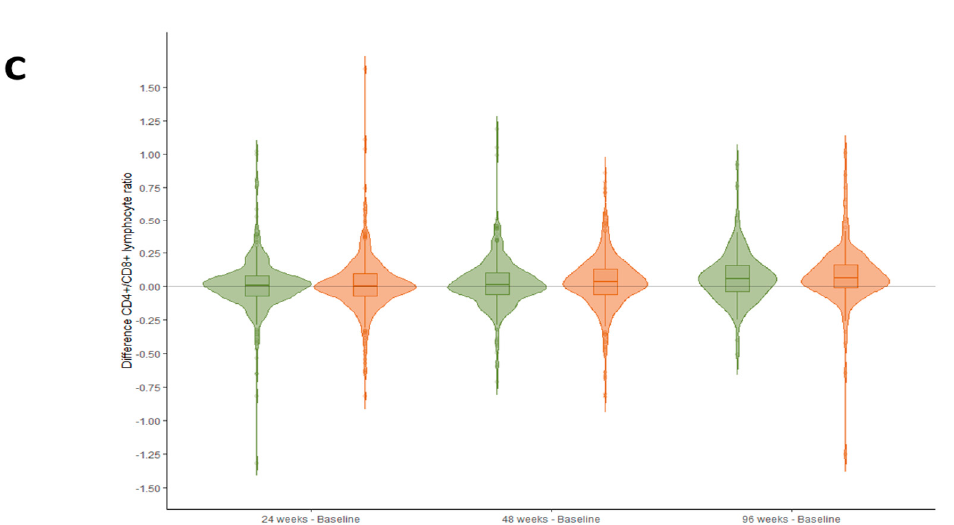
Figure 2. Immunological variation in CD4 T-cell ( A ), CD8 T-cell ( B ), and CD4/CD8 ratio ( C ) param- eters between baseline and weeks 24, 48, and 96 of treatment in the DTG plus 3TC and DTG plus RPV cohorts.